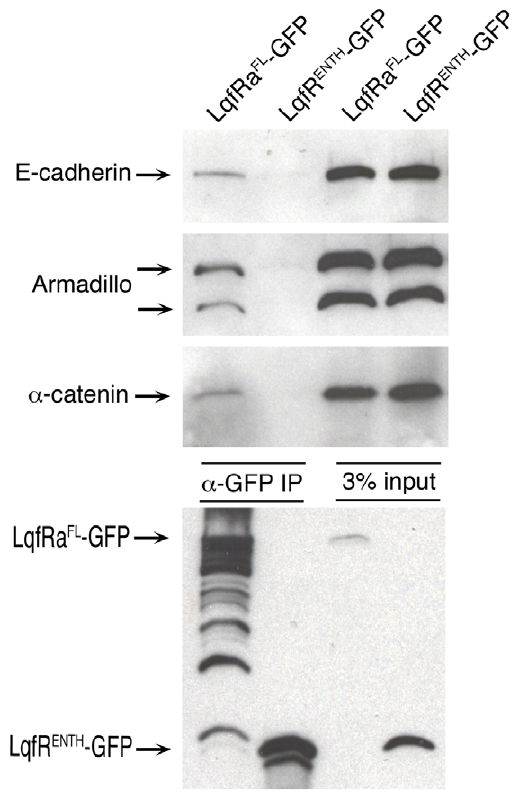
Figure 7. Coimmunoprecipitation of LqfRa and Wingless pathway proteins. Shown is a blot of protein extracts, before and after immunoprecipitation, from embryos expressing either LqfRa FL -GFP or LqfRa ENTH -GFP as a negative control. The LqfR protein fusions were expressed from UAS transgenes using an Actin5C-gal4 driver. The two leftmost lanes ( a -GFP IP) are immunoprecipitates using GFP antibodies, and the rightmost lanes (3% input) are aliquots of the protein extracts used, loaded to show that equivalent amounts of protein were present in each extract subjected to immunoprecipitation.